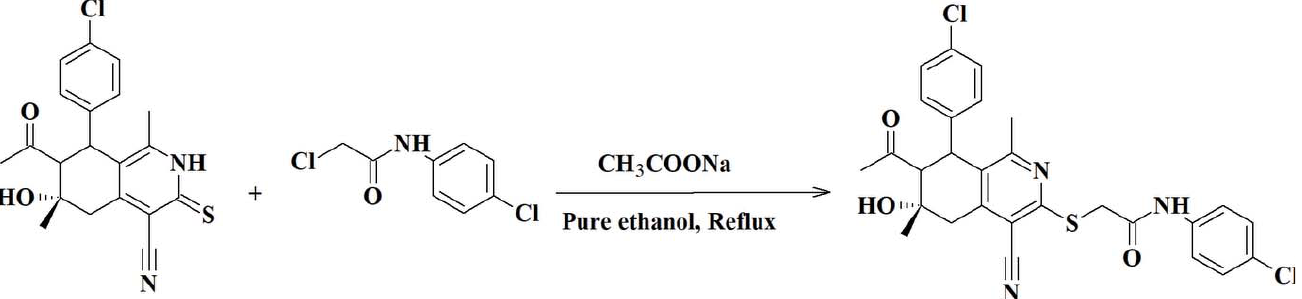
Figure 6 Synthesis scheme for 2-{[7-acetyl-8-(4-chlorophenyl)-4-cyano-6-hydroxy-1,6-dimethyl-5,6,7,8-tetrahydroisoquinolin-3-yl]sulfanyl}- N -(4-chlorophen- yl)acetamide.